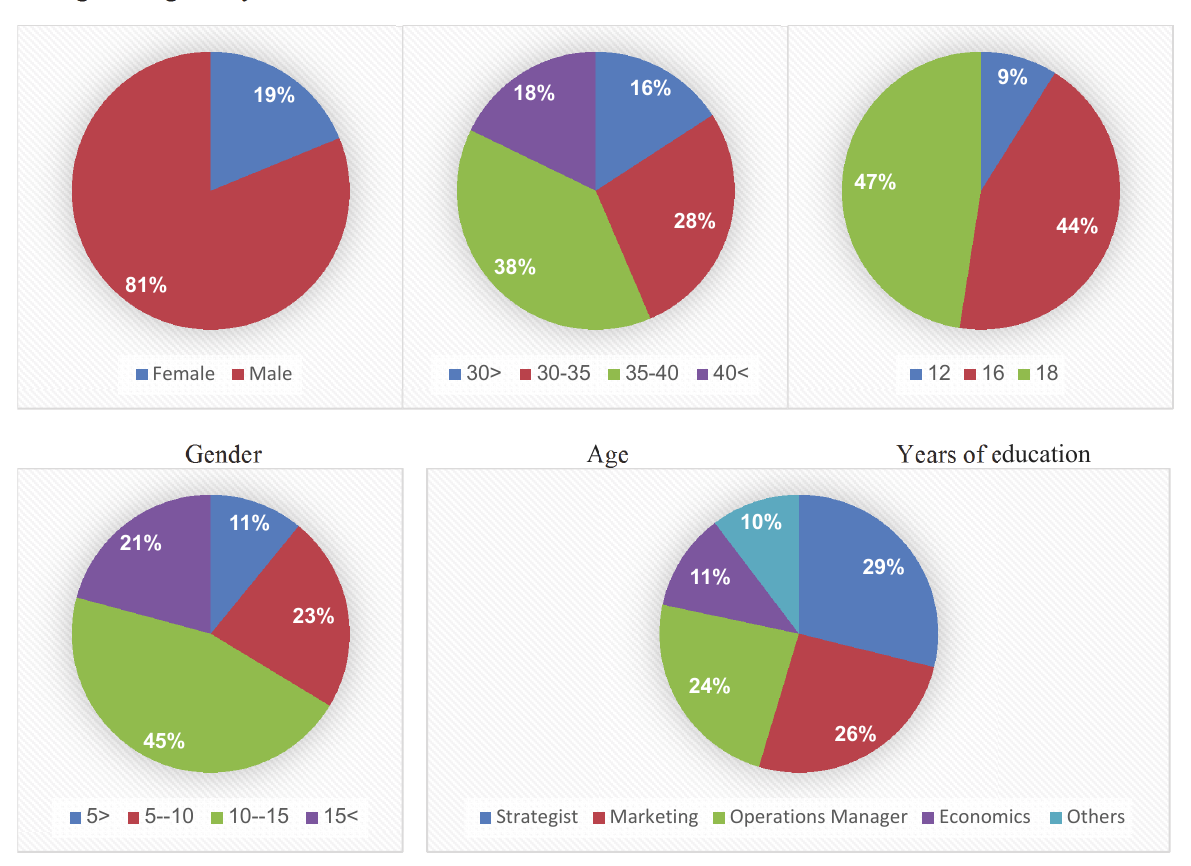
Fig. 2. Personal characteristics of the